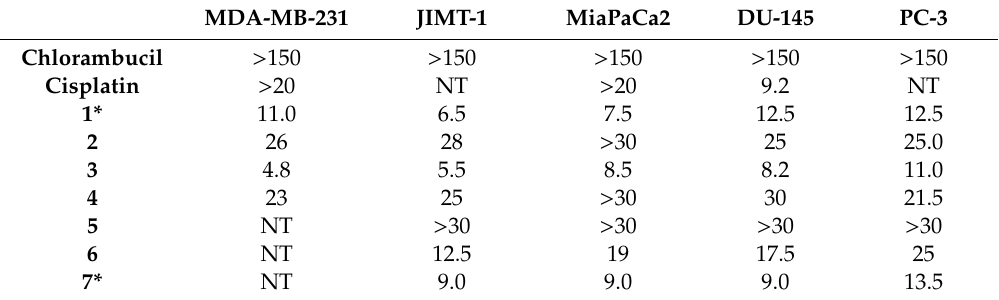
Figure 2. E ff ects of compounds 2 – 6 on the viability of MDA-MB-231, JIMT-1, DU-145, and MiaPaCa2 cells lines. Twenty four hours after plating, cells were incubated with compounds 2 – 6 (0–30 µ M) for 48 h. Cell viability relative to vehicle control was measured by MTS assay. The results represent the mean ± standard deviation of 6 independent determinations. Table 1. CC 50 values ( µ M) of chlorambucil, cisplatin, and compounds 1–7 on a panel of human epithelial cancer cell lines: breast (MDA-MB-231, JIMT1), pancreas (MiaPaCa2) and prostrate (DU145, PC3).